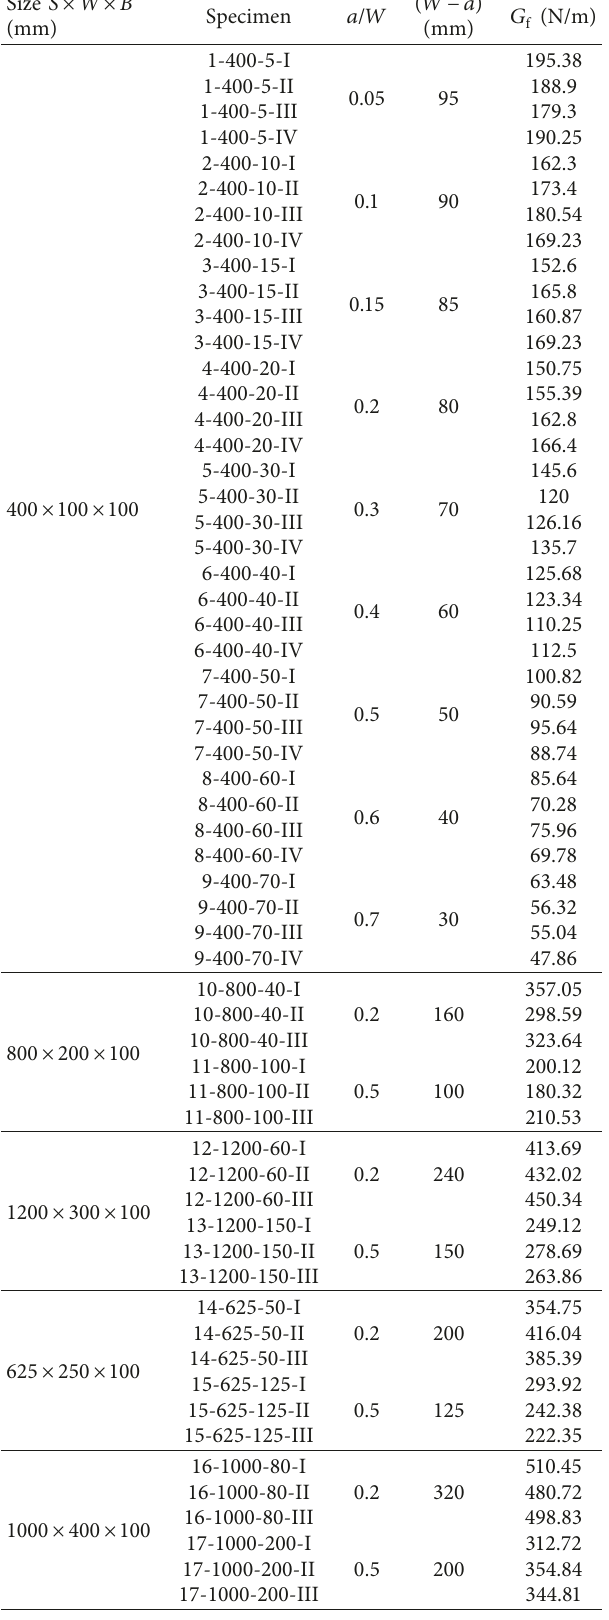
Table 3: Specimens with different sizes and the corresponding fracture energy.